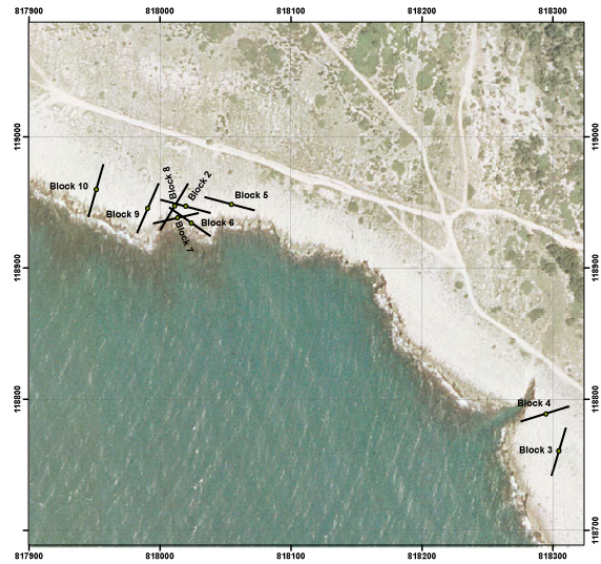
Fig. 4. Long axis orietation of elongated boulders studied (indicated as black full